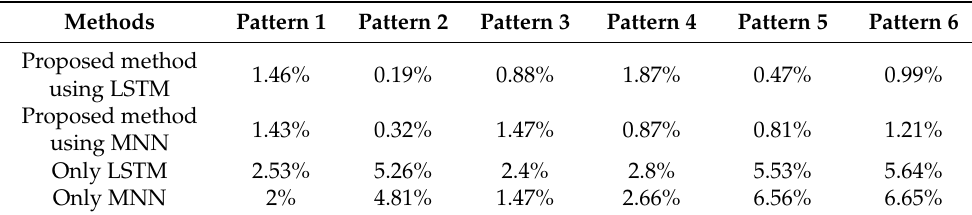
Table 7. The SOC estimation error for each model when six voltage parameters were input.